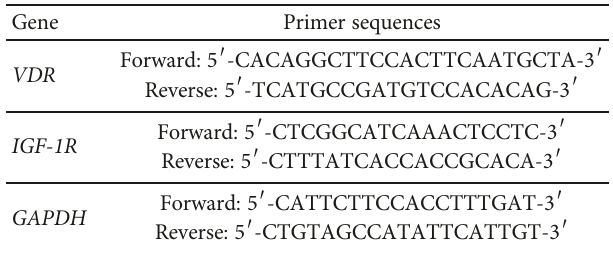
Table 1: Primer sequences for